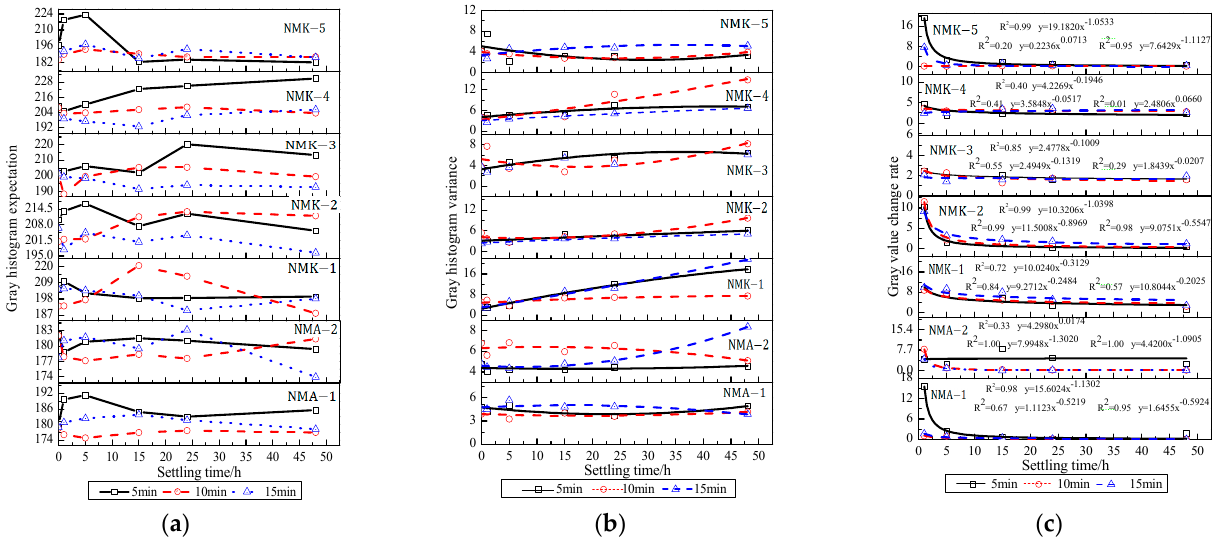
Figure 6. Relationship between the gray histogram k , f , gray change rate, and sedimentation time of nanoclay suspensions. ( a ) k and settlement time; ( b ) f and settlement time; ( c ) gray change rate and settlement time.